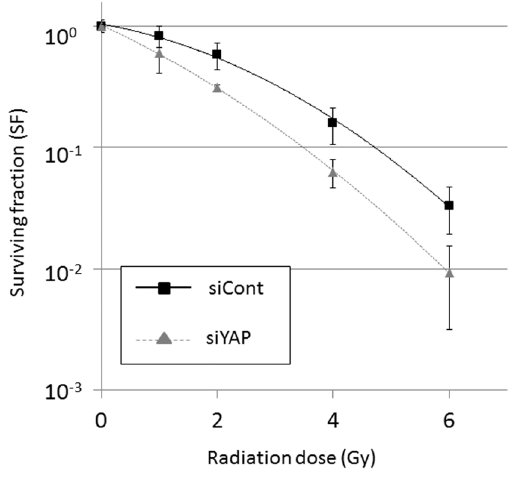
Figure 5. Clonogenic assay in HEC-1-B cells after radiation exposure. Knockdown of YAP expression by siRNA reduced clono- genic survival in HEC-1-B cells, resulting in an increase in radiation sensitivity with a dose enhancement factor at 10% survival (DEF 0.1) of 1.36. Results are shown in means 6 standard deviations (bars) in triplicate experiments. Similar trends were obtained in other three independent experiments.